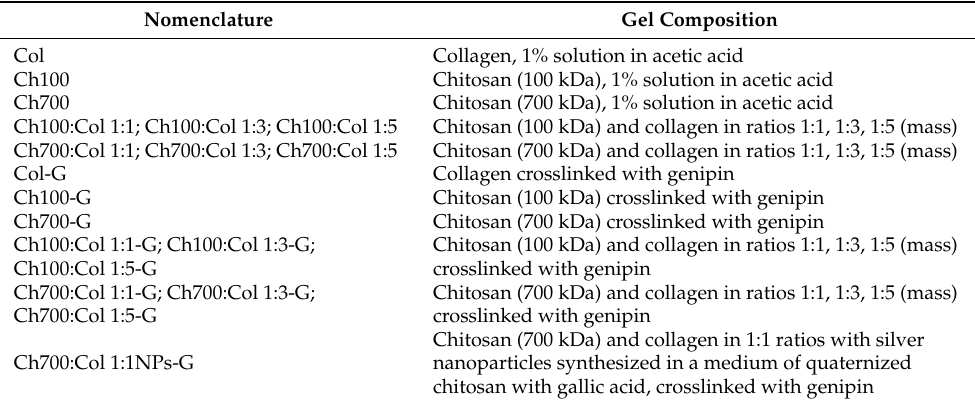
Table 4. List of abbreviations for the hydrogels obtained using different ratios of chitosan and collagen (1:1, 1:3, 1:5) crosslinked with a 0.03% genipin solution (G).